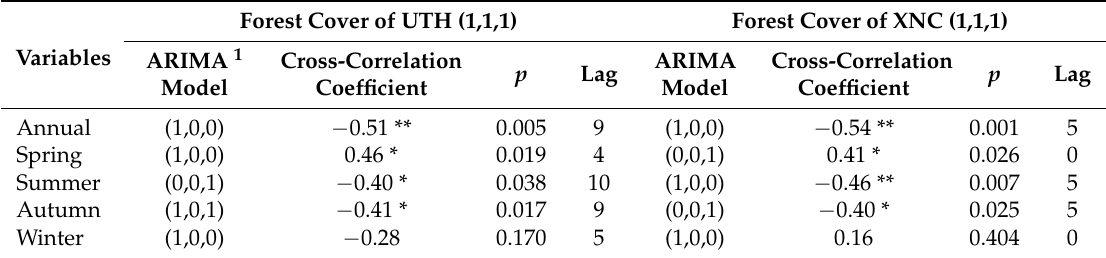
Table 3. Cross-correlations between forest cover and hydrological